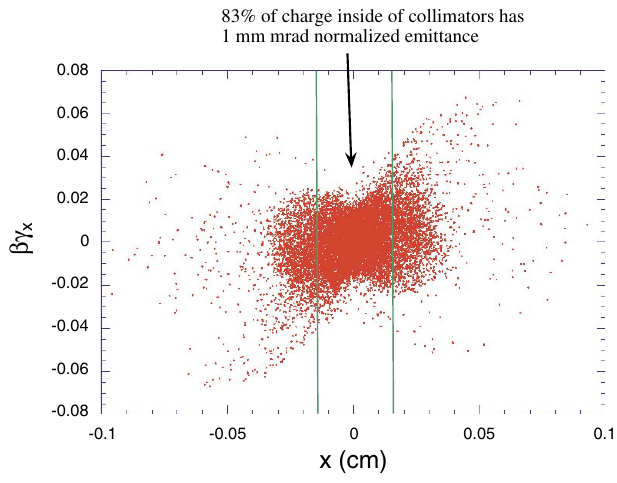
FIG. 7. (Color) Evolution of the rms transverse beam size and emittance for 1 nC beam in the ORION photoinjector, velocity- bunching case, from PARMELA simulation.